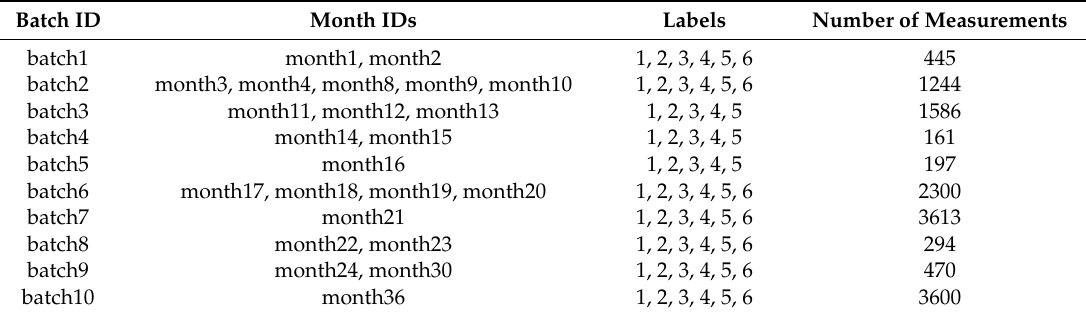
Table 4. Basic Data in the Dataset.